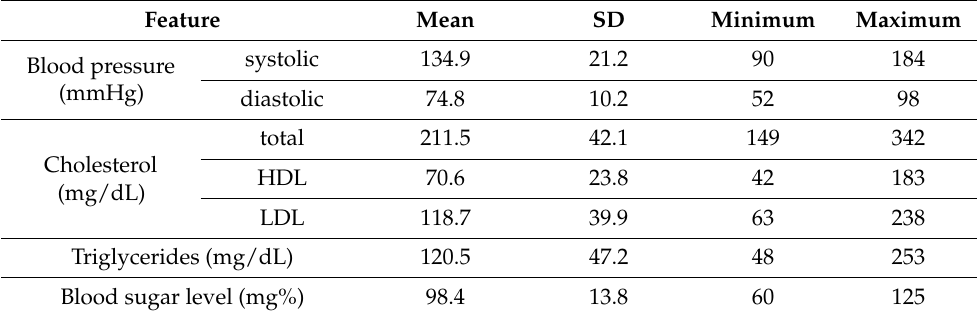
Table 2. Laboratory tests results and blood pressure of the women in the study